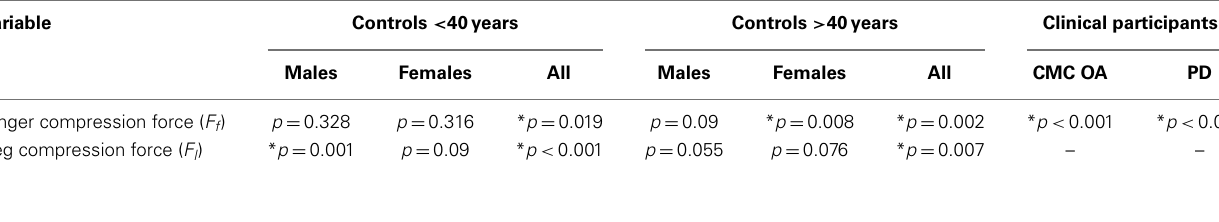
Table 3 | Summary of linear regressions of compression force with age